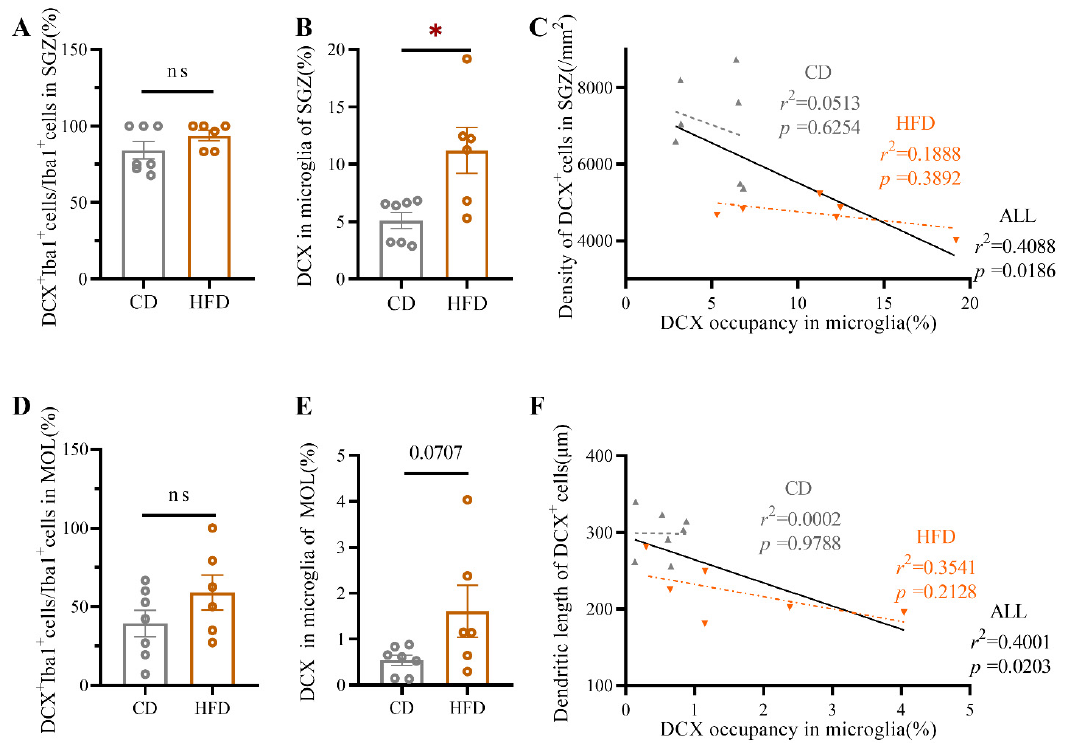
Figure 8. Quantification of the changes in microglial phagocytosis of newborn neurons in the mouse ventral hippocampus induced by HFD consumption in adolescence. ( A , D ) The percentage of DCX + Iba1 + cells among Iba1 + cells in the vSGZ and vMOL in CD- and HFD-fed mice. ( B , E ) Quantification of the percentage of the microglial volume occupied by DCX + inclusions in the vSGZ and vMOL in CD- and HFD-fed mice. ( C ) Linear regression analysis of the microglial area occupied by DCX + inclusions and the density of DCX + cells in the vSGZ. ( F ) Linear regression analysis of the microglial area occupied by DCX + inclusions and the total dendritic length of DCX + cells in the vDG. Linear regressions are indicated by gray dotted lines (for CD-fed mice), orange dotted lines (for HFD-fed mice), and solid black lines (both CD and HFD-fed mice). The data are expressed as the mean ± SEM ( n = 6–7 mice per group). When the HFD group was compared with the CD group, the data were analyzed using Student’s t- test. ns, not significant; * p < 0.05.